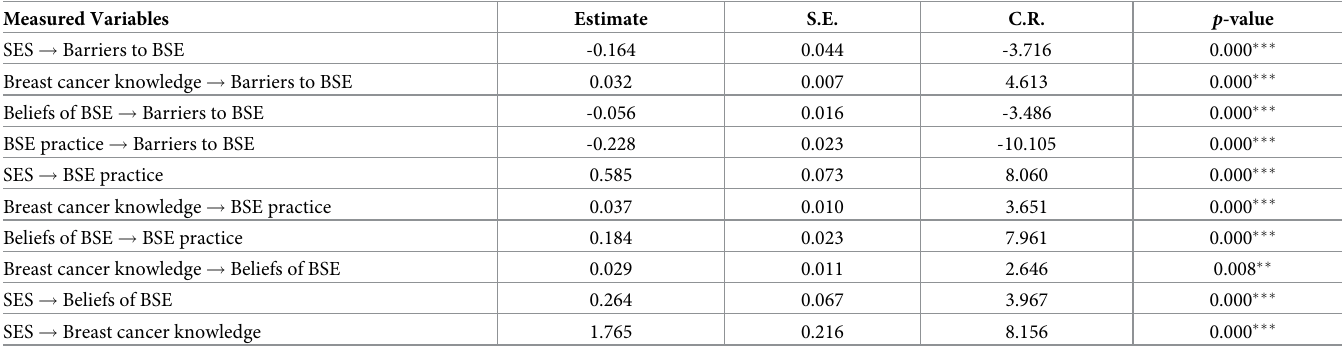
Table 4. Regression weight of